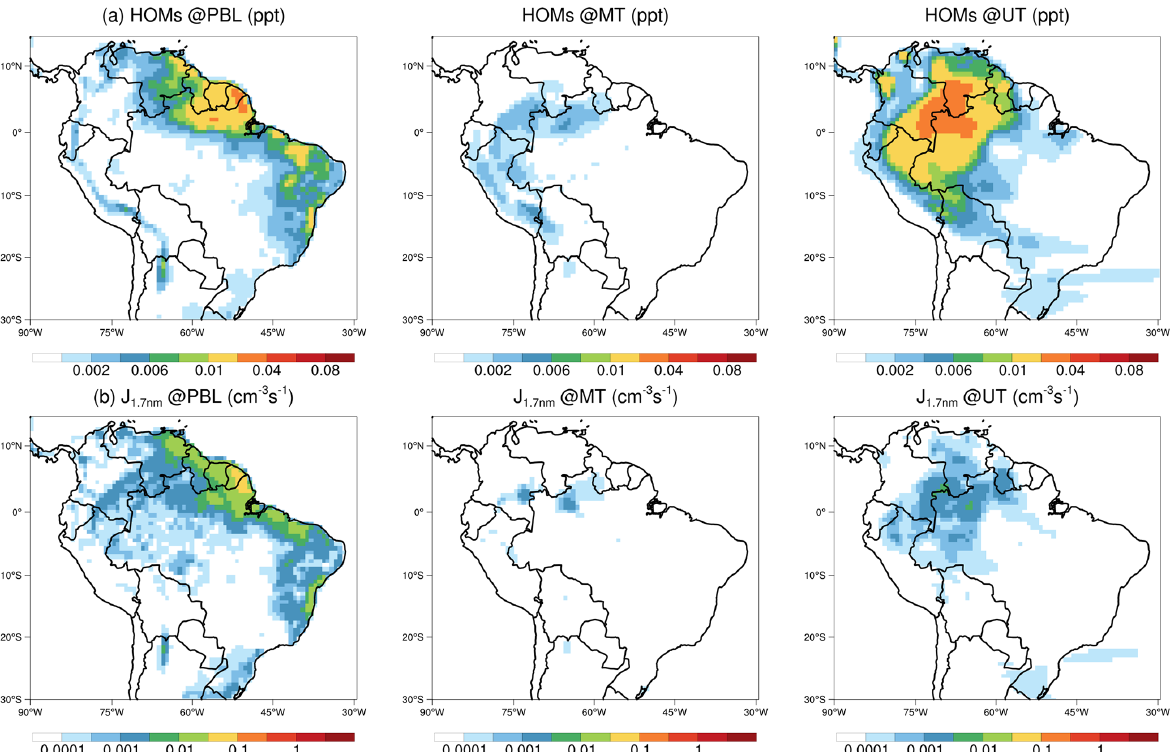
Figure A11. Horizontal distribution of (a) HOMs and (b) organic nucleation rate averaged over 1 September–1 October 2014 from the BNUnoT case, all at